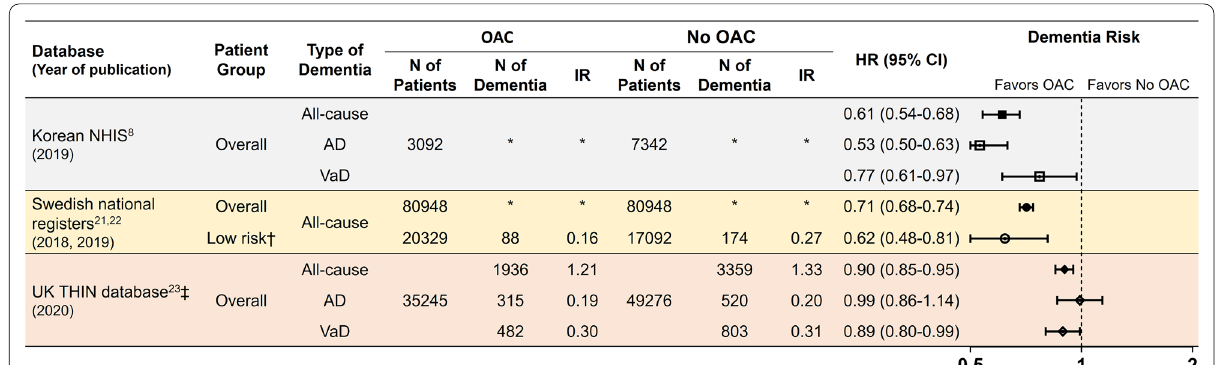
Fig. 2 Risk of dementia in patients with AF using oral anticoagulants or not in data from Asian and European populations. AD Alzheimer’s disease, IR incidence rate, OAC oral anticoagulant, THIN The Health Improvement Network, VaD vascular dementia. *Not presented in the article. †CHA 2 DS 2 ‑VASc 0 (male) or 1 (female). ‡Incidence rates and hazard ratios were inverse probability of treatment